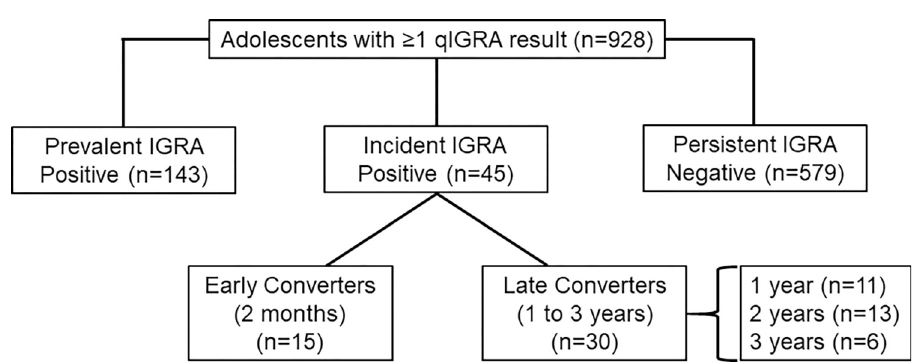
Fig 1. Analysis groups based on quantitative IGRA results. Among 928 subjects with � 1 qIGRA result, 161 (17.3%) failed to meet strict criteria for inclusion in an analysis group, including 107 (11.5%) who were negative at baseline, but did not participate in the vaccine study and had no subsequent samples, 23 (2.5%) who had borderline or invalid baseline qIGRA, 19 (2.0%) whose only post-baseline non-negative qIGRA was borderline, and 12 (1.3%) who were excluded from the vaccine study because their baseline mIGRA was borderline or positive, but their qIGRA was not